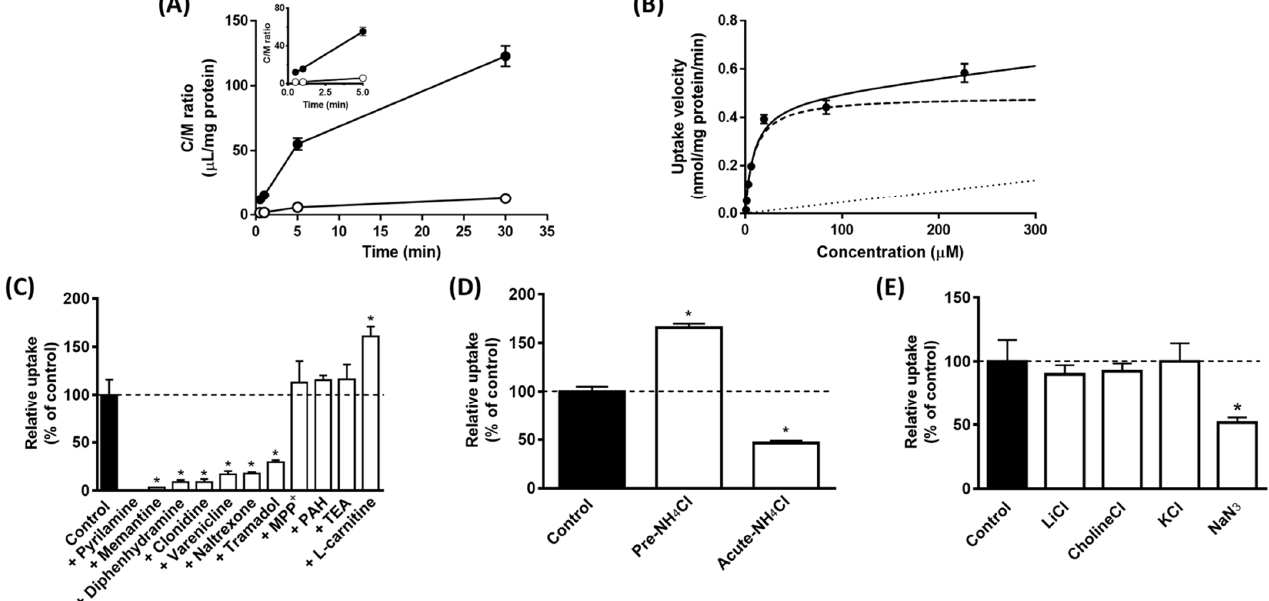
Figure 6. Transport characteristics of pyrilamine analogue in hCMEC/D3 cells. ( A ) Time- and temperature-dependent uptake experiments were performed at 37 ◦ C (closed circles) and 4 ◦ C (open circles) for up to 30 min. ( B ) The concentration-dependent uptake experiments were performed at 37 ◦ C for 1 min (solid line). The dashed and dotted lines represent the saturable and non-saturable uptake components, respectively. ( C ) Inhibition experiments were performed at 37 ◦ C for 1 min in the absence and presence of several inhibitors (1 mM). The black and white columns indicate inhibitory effects as percent of the control. ( D , E ) Effects of intracellular pH, extracellular Na + , membrane potential and metabolic energy on pyrilamine analogue uptake by hCMEC/D3 cells. Cellular uptake in the C-E is shown as percent of the control. Each value and column represent the mean ± standard error ( n = 4). * p < 0.05 indicates a significant difference versus the control.